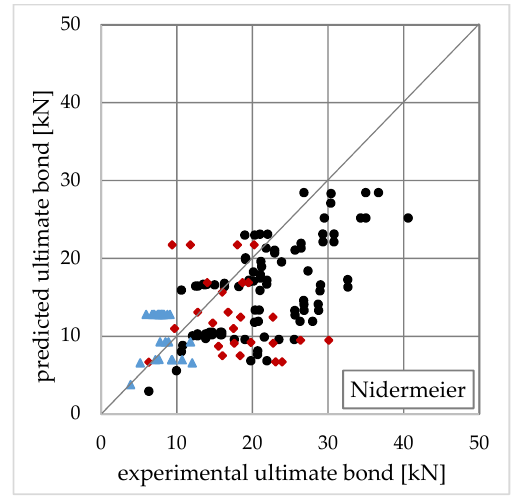
Figure 5. Test vs. predicted bond force using the Taljsten model [17]. Appl. Sci. 2020 , 10 , 8593